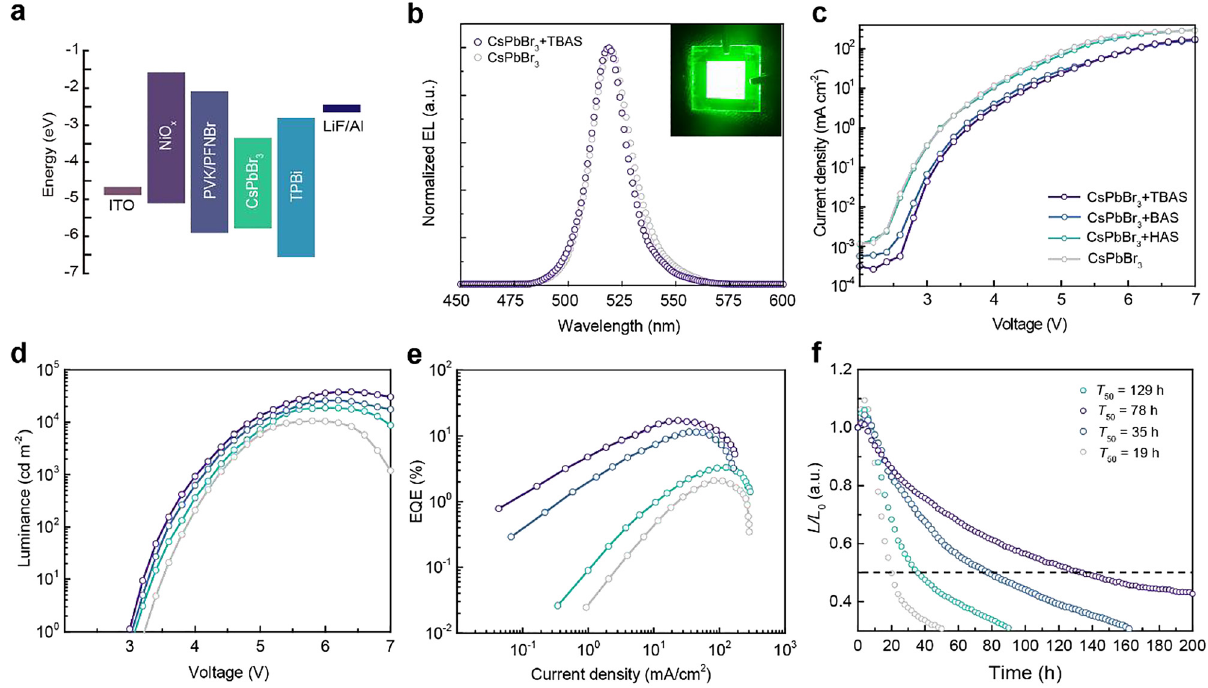
Figure 5: Electroluminescence (EL) performances characterization of the CsPbBr 3 PeLEDs. (a) Energy level structure of each functional layer in the PeLED device. (b) EL spectra of original and 4-(trifluoromethyl) benzoate acid sodium salt (TBAS)-containing CsPbBr 3 PeLEDs, the inserted picture is the TBAS-containing device operated under biased voltage of 4.0 V. (c) J – V , (d) L – V , and (e) EQE – J curves of original CsPbBr 3 PeLED and CsPbBr 3 PeLEDs incorporated with hexanoic acid sodium salt (HAS), benzoic acid sodiumsalt(BAS)and4-(tri fl uoromethyl)benzoateacidsodiumsalt(TBAS),respectively.(f)Thestabilitymeasurementataninitialluminance of 100 cd m − 2 for different CsPbBr 3